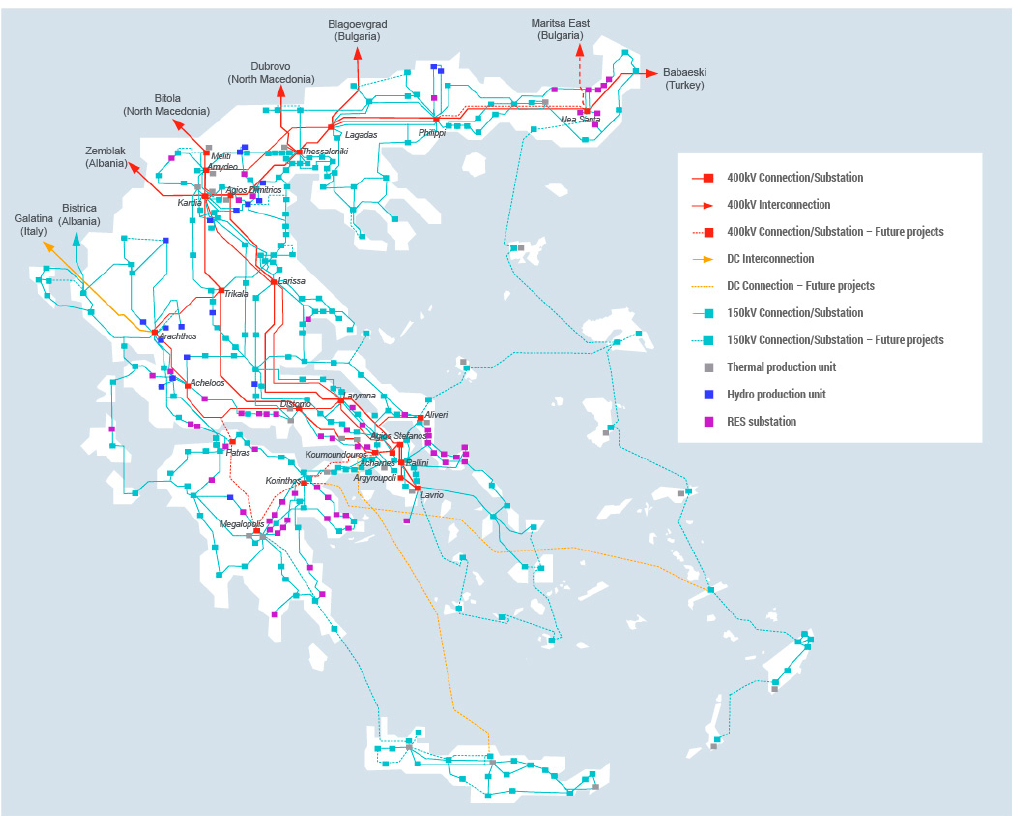
Figure 1. The existing interconnection electricity network production (conventional and renewable energy sources) [4].